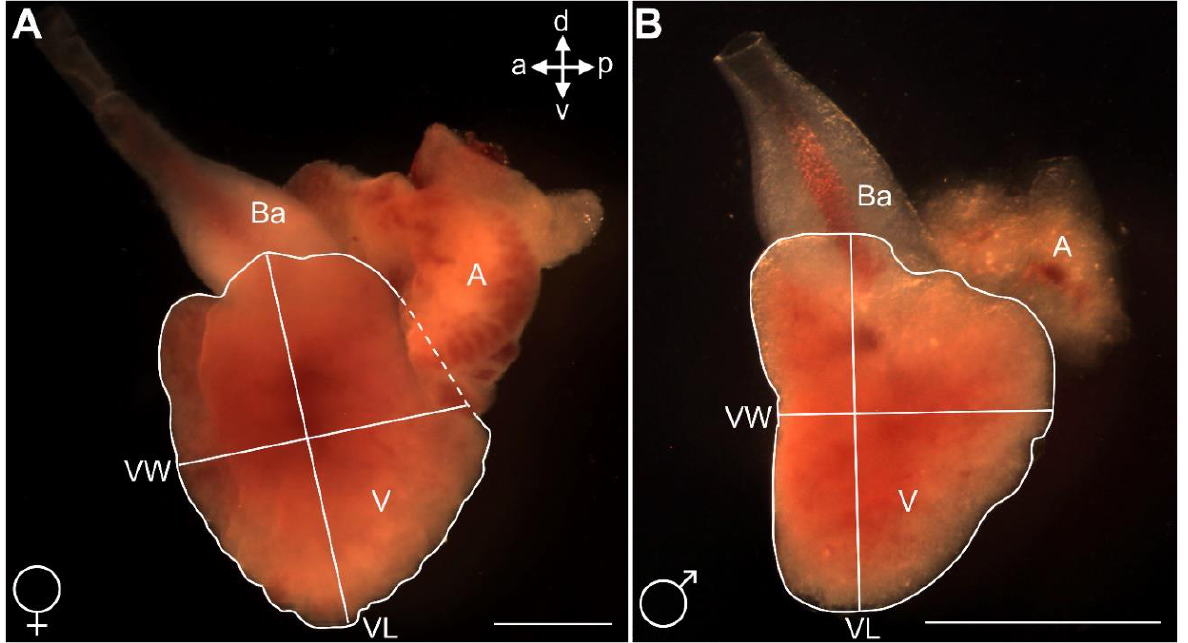
Figure 4. Freshly explanted hearts of adult ( A ) female and ( B ) male G. holbrooki , with schematic measurements of ventricle length (VL) and width (VW). The solid lasso line outlines the ventricle boundaries laterally. Bulbous arteriosus (Ba), ventricle (V), atrium (A). The horizontal (VW) and vertical (VL) lines correspond to the width and length of the ventricle. a, v, p, and d represent anterior, ventral, posterior, and dorsal, respectively. Scale bars = 500 μm.